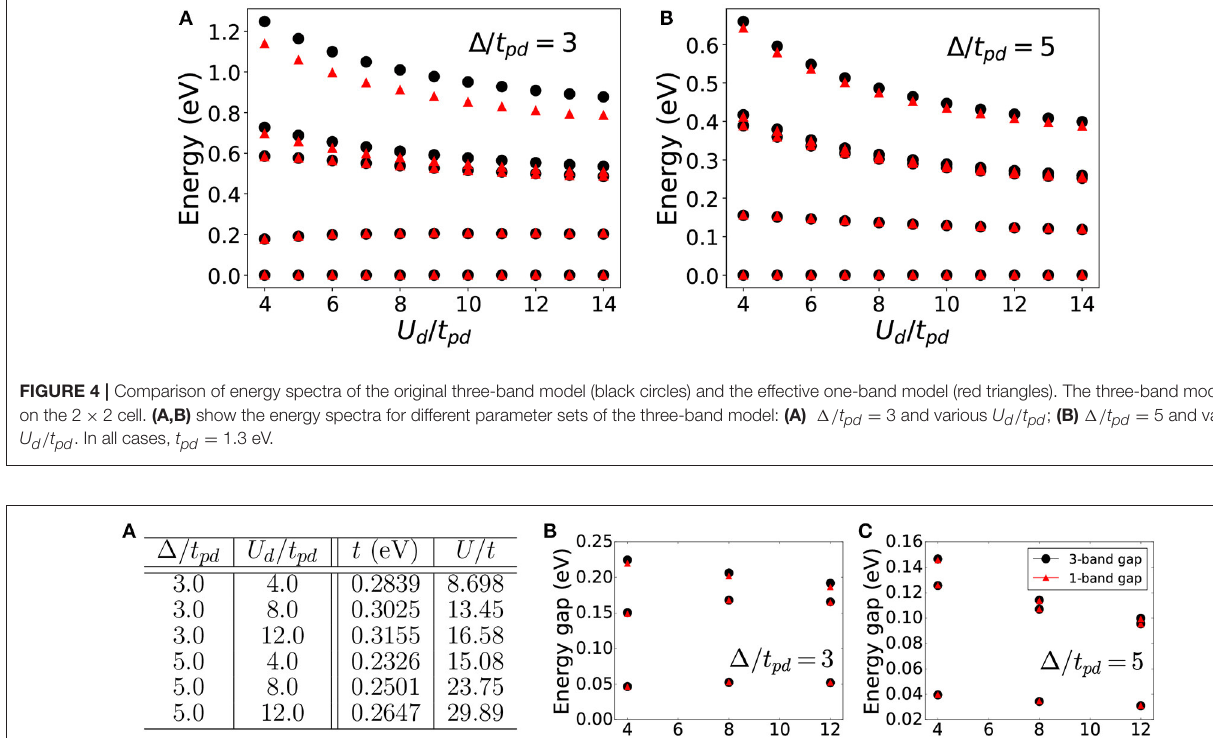
FIGURE 5 | Multiscale prediction of the effective one-band model. (A) shows the parameters of the effective one-band model obtained from DMD on a small cell, the 4-copper (2 2) cell. These parameters were then directly used to predict the energy spectra of a larger cell, the 8-copper (2 √ 2 × spectra (red triangles) in comparison to the exact spectra (black circles) of the three-band model of different parameters (different 1/ t pd and U d / t pd where t pd